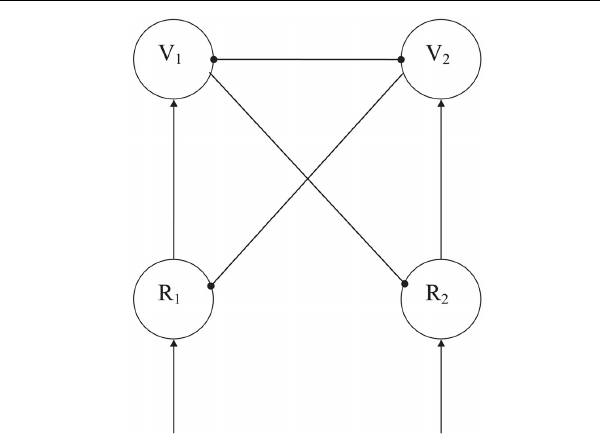
FIGURE 2 |A two input node competitive network with separate excitatory (R) and inhibitory (V) nodes. Arrows denote excitatory connections, globules inhibitory connections.The network is a simplified variant (i.e., without oscillations occurring) of the schematic network that evolved in the simulations of Heerebout and Phaf (2010b). Competition is implemented by strong mutual inhibition of theV-nodes.The winning V-node eventually suppresses its competitor and the corresponding R-node, and releases its own R-node from the inhibition by the competingV-node.